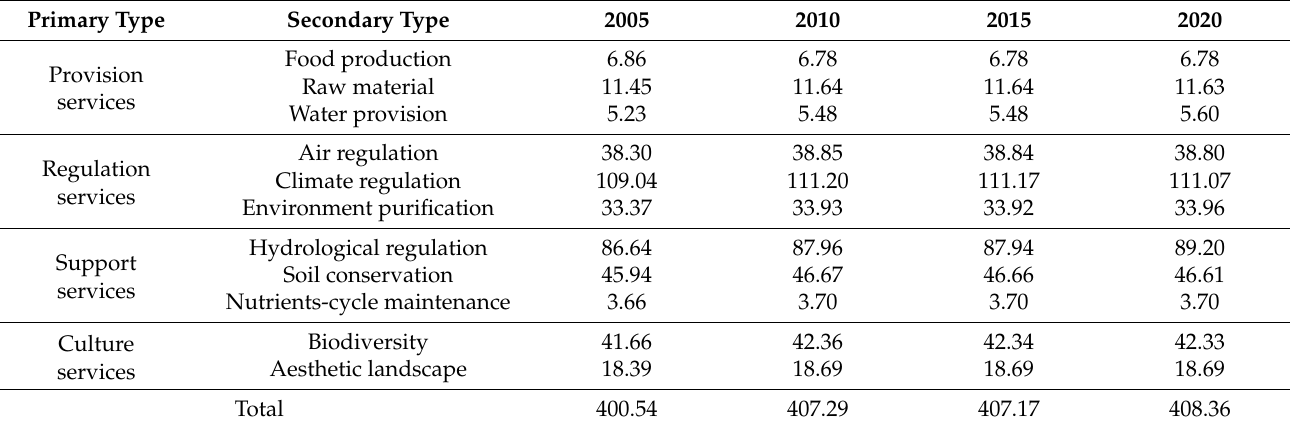
Figure 3. ESVs of counties in Nujiang Prefecture from 2005 to 2020. Table 2. Temporal evolution characteristics of ESVs in Nujiang Prefecture (×CNY 10 2 million).